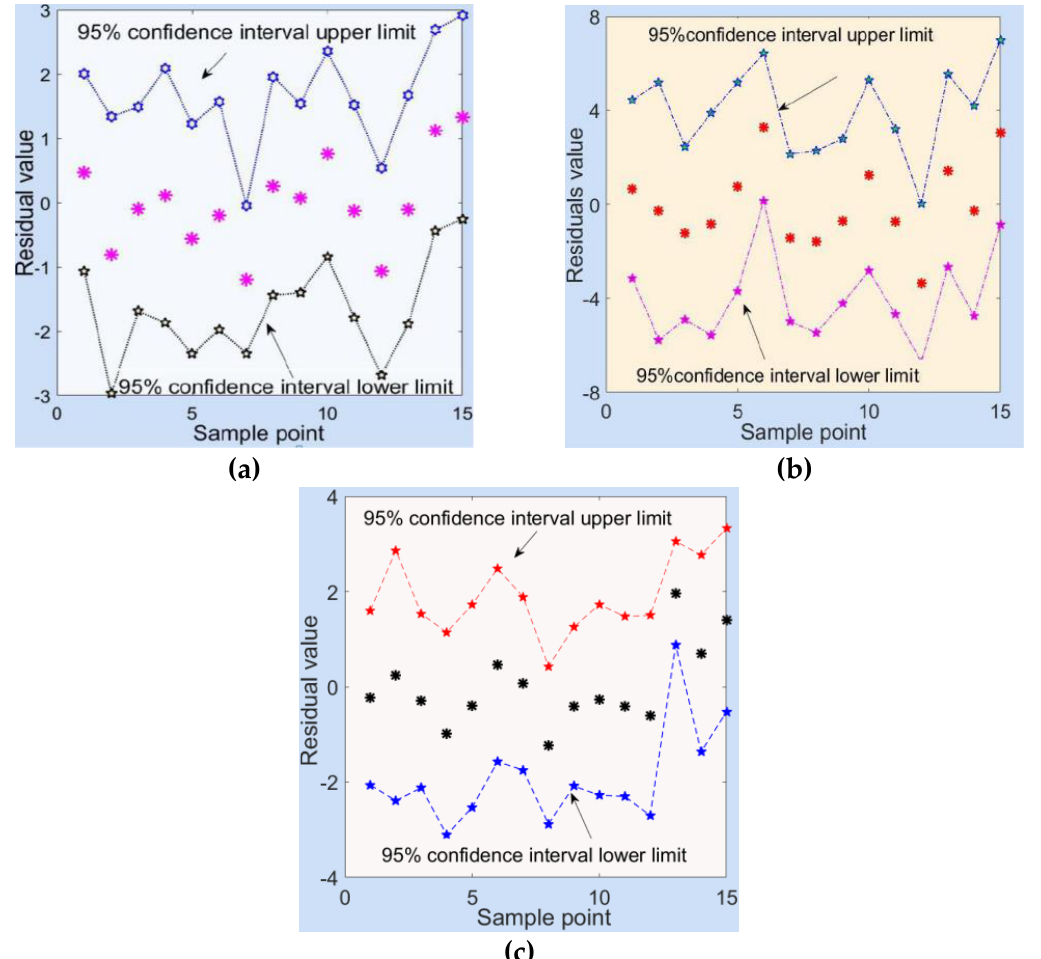
Figure 13. Residual value analysis. ( a ) Residual value of compressive strength; ( b ) residual value of the bond stress; and ( c ) residual value of the adhesion stress. Table 13. Error analysis of the fitting results.